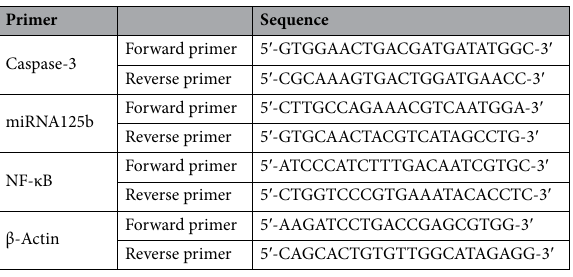
Table 2. Primer sequences used for